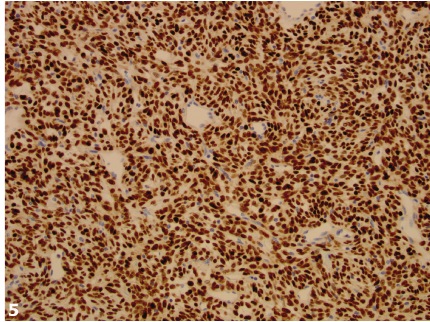
Figure 5: The neoplastic cells demonstrate strong nuclear positivity withantibodytoSTAT6byimmunohistochemistry(STAT6,original magnification ×